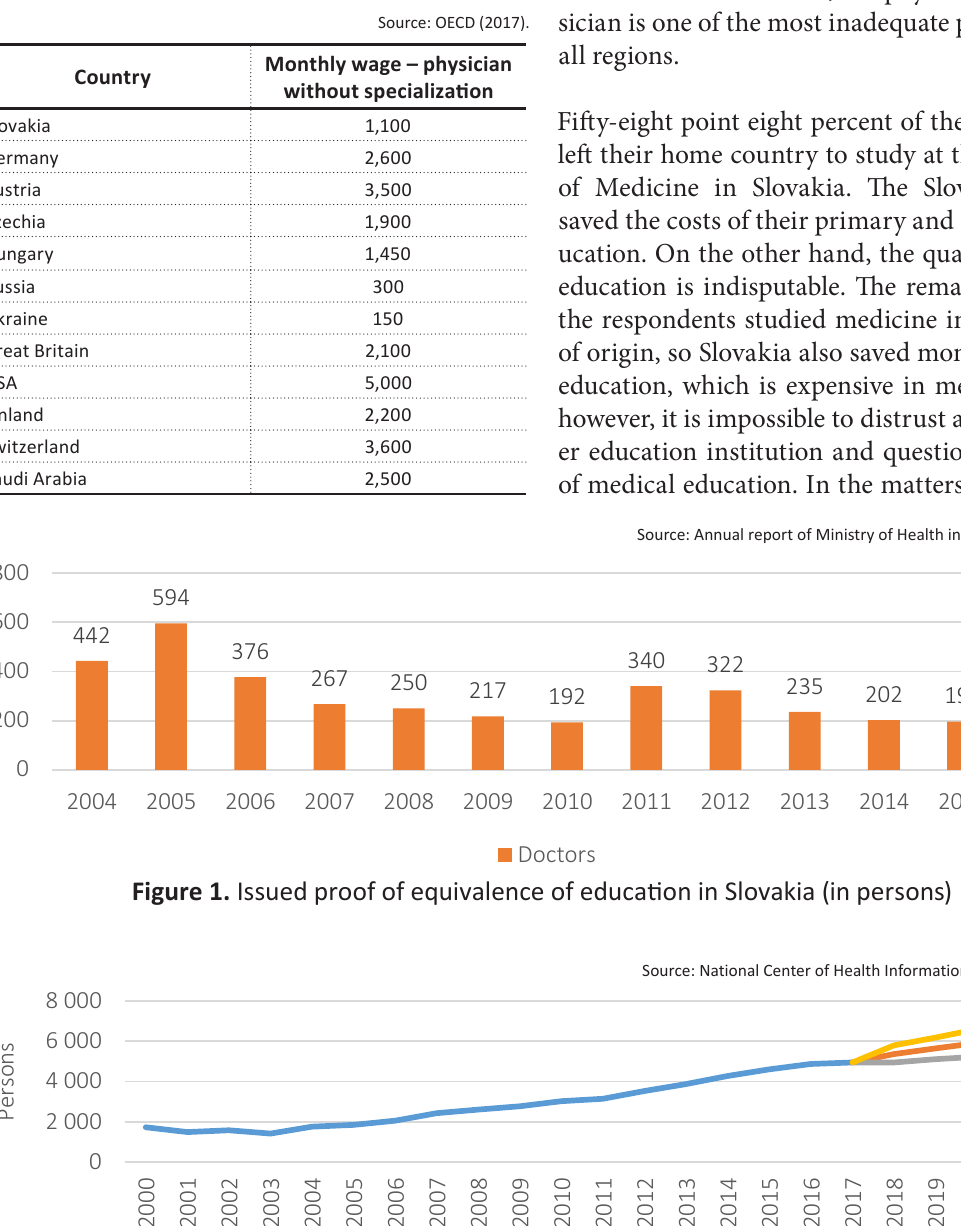
Table 2. Gross wages of novice physicians in the selected countries in 2017